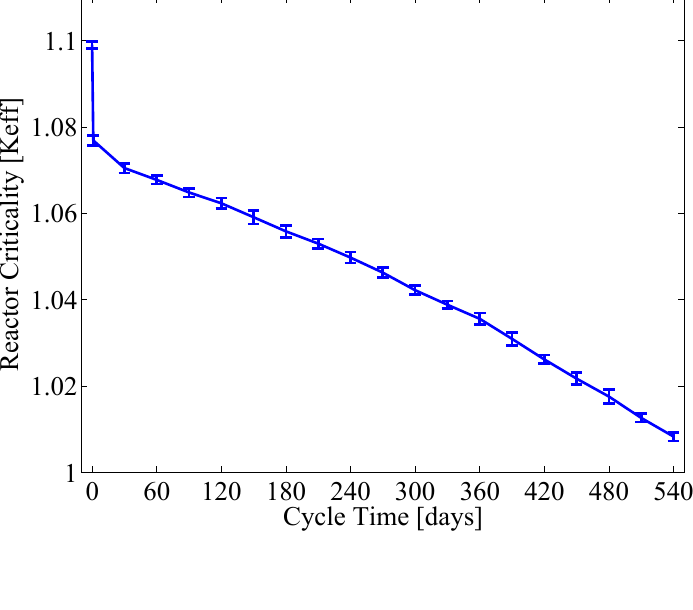
Figure 11. Reactor Criticality. The reactor criticality must be above 1 at the end of the campaign. This figure shows the drop in K = 1.008 ± 0.001 at end of K eff